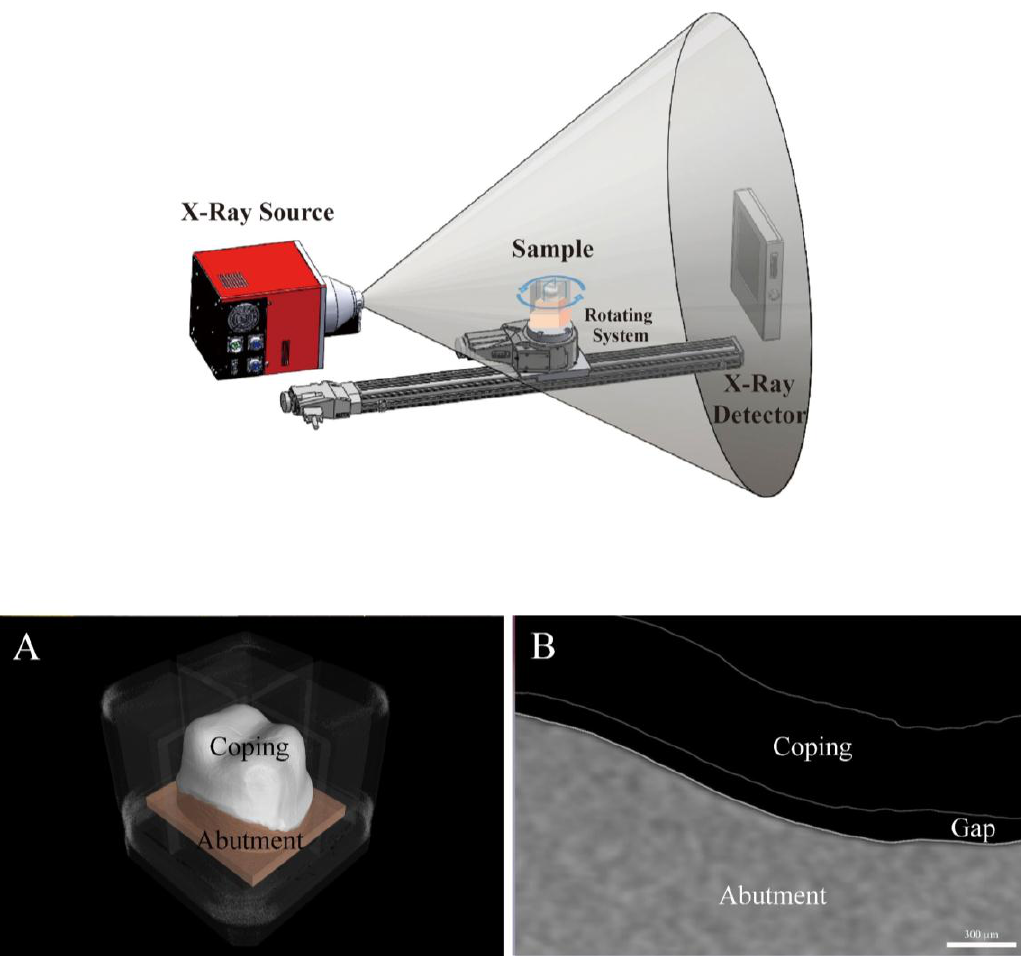
Figure 7. Schematic of micro-computed tomography (MCT) from the left. ( A ) Three-dimensional image obtained through MCT; ( B ) cross-sectional image of MCT for the occlusal gap.